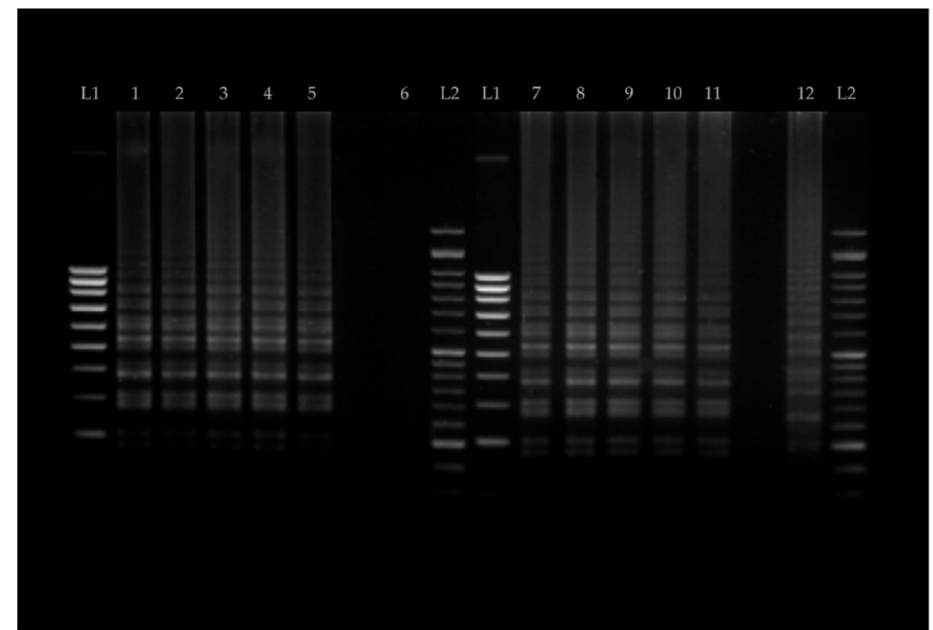
Figure 6. Inclusivity of the LAMP assay evaluated through agarose gel electrophoresis. The exper- iments were conducted at 62 ◦ C (lanes 1 to 6) and 63 ◦ C (lanes 7 to 12). Lanes 1 and 7, Lm 1/2a; lanes 2 and 8, Lm 4b; lanes 3 and 9, Lm 1/2b; lanes 4 and 10, Lm 1/2c; lanes 5 and 11, Lm reference strain (EGDe); lanes 6 and 12, non-target DNA control. Lanes L1 and L2, molecular weight marker (NZYDNA Ladder V and